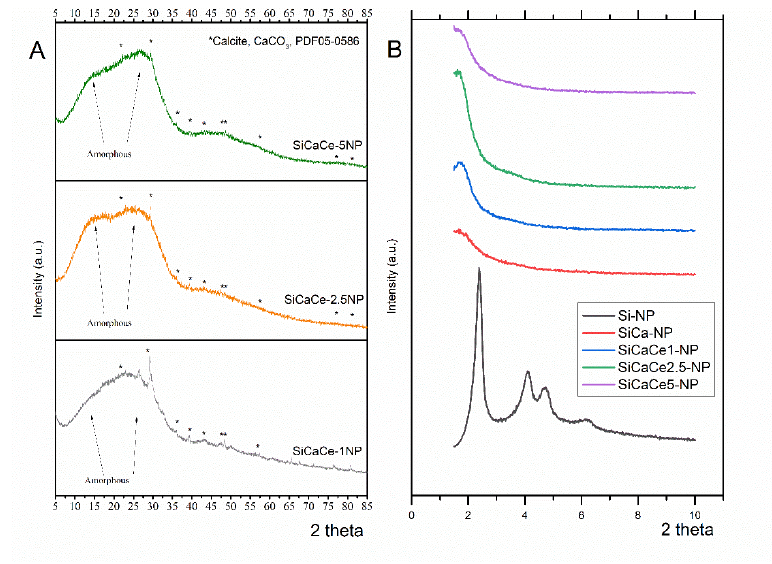
Figure 3. Wide- ( A ) and small-angle ( B ) XRD of NPs.